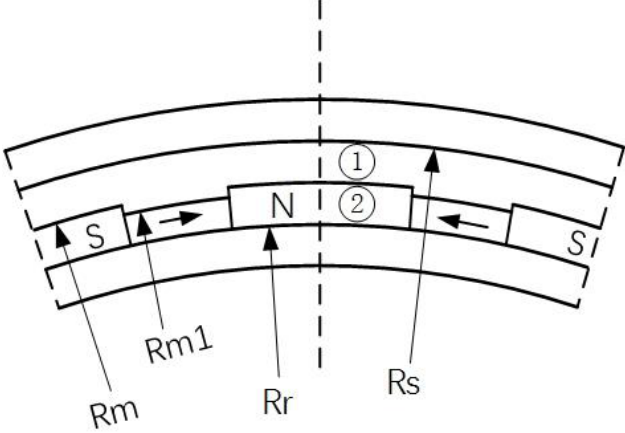
Figure 2. Motor model in one period.